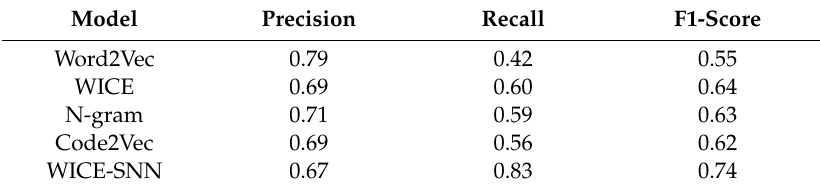
Figure A3. Performance Change with Parameter (Threshhold ∈ [0.1, 1]). Table A1. Results on Dataset1. Model Precision Recall